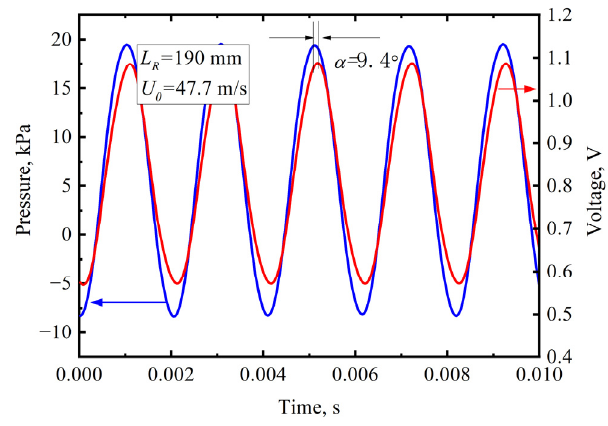
Figure 7. Synchronized waveforms of acoustic pressure and output voltage.